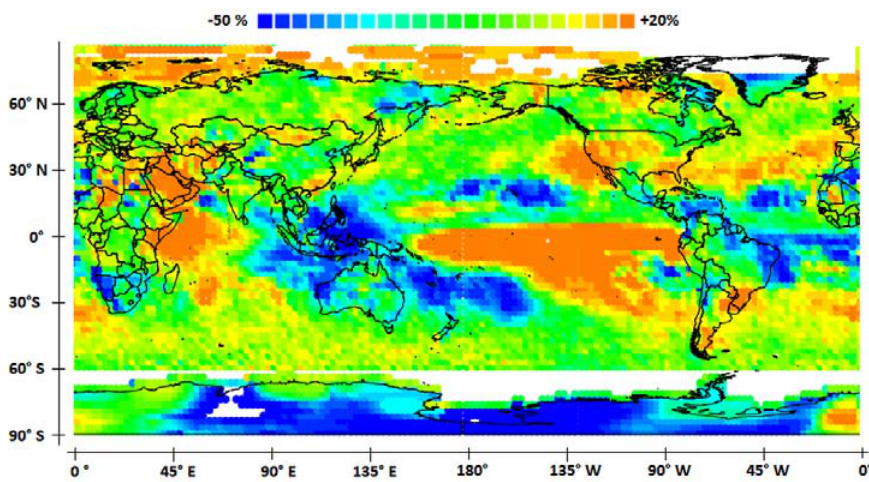
Figure 8. Impact of the ENSO from the variability of precipitation height. Unlagged and weakly lagged events are considered.